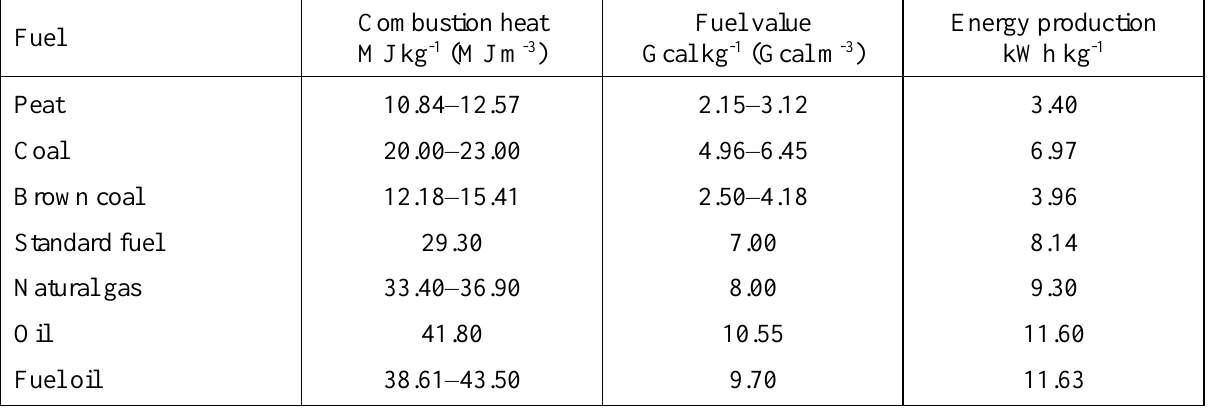
Table 3. Energy characteristics of different fuels (authors’ own data).